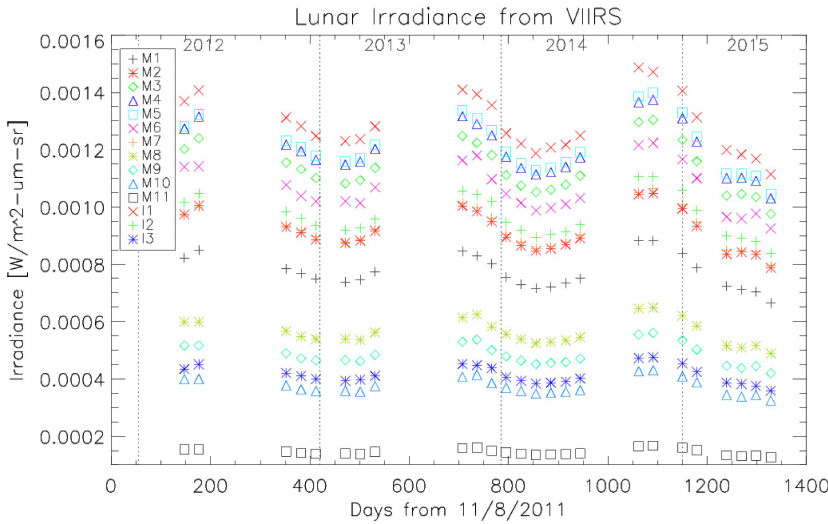
Figure 6. Lunar irradiance from VIIRS lunar observations for all RSBs of VIIRS.